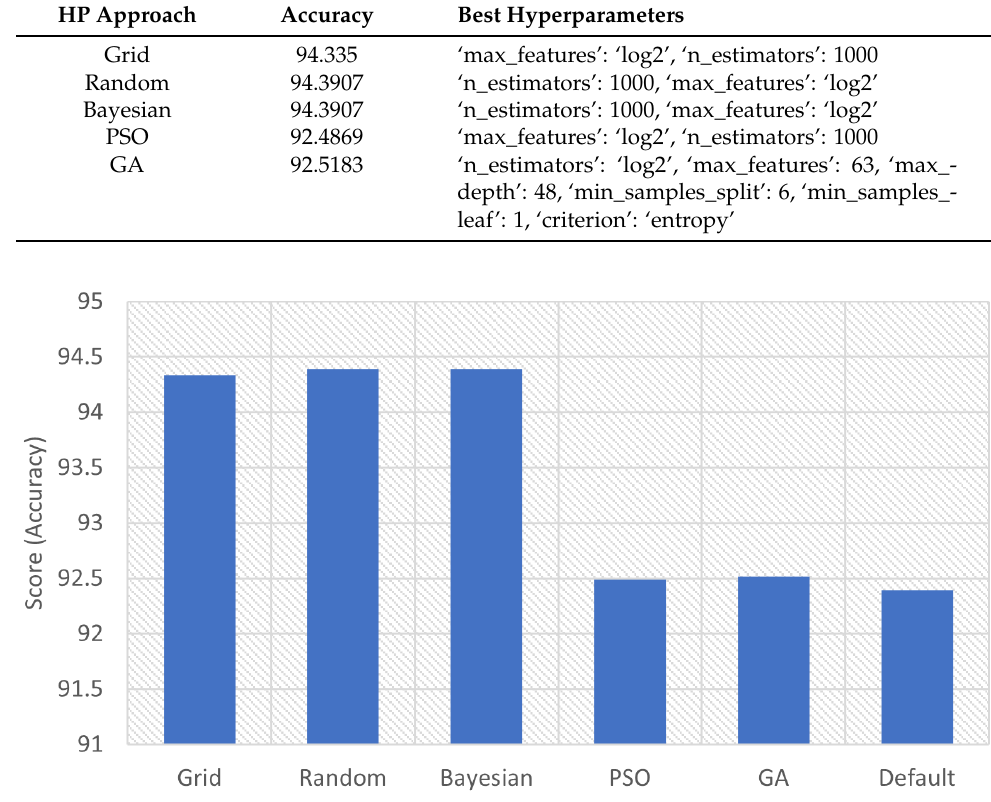
Table 4. Hyperparameter tuning for Random Forest.